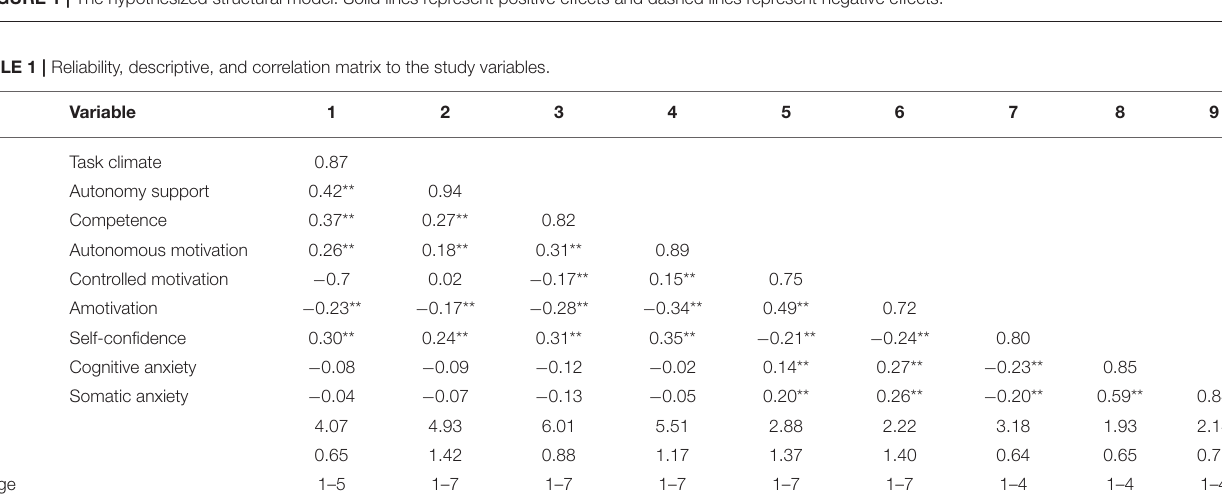
FIGURE 1 | The hypothesized structural model. Solid lines represent positive effects and dashed lines represent negative effects.